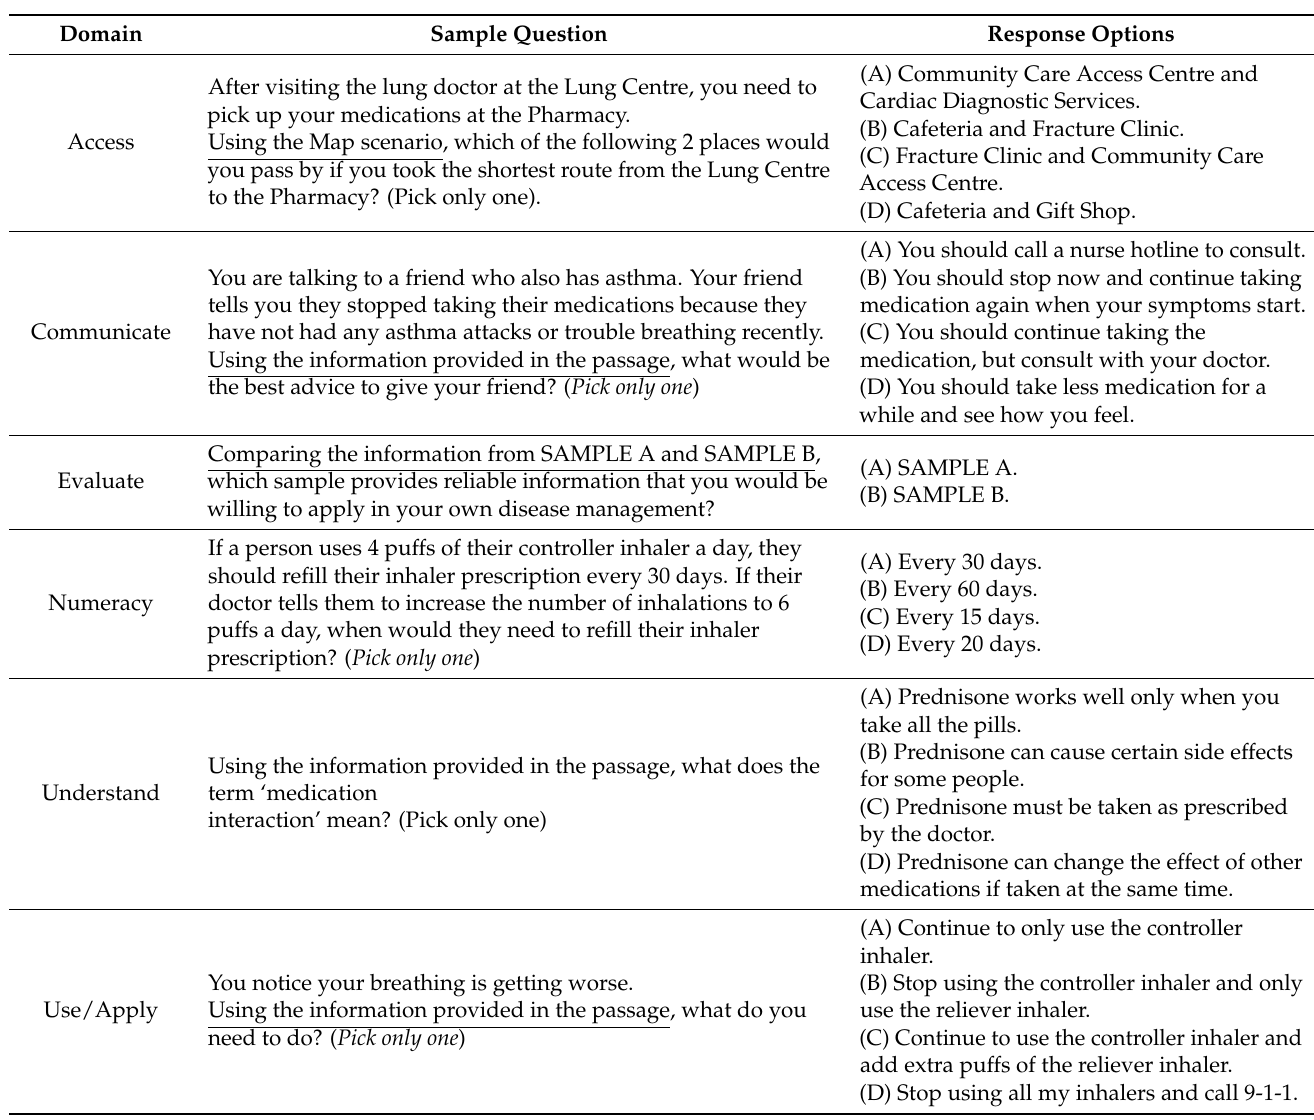
Table 2. The sample questions for each HL domain